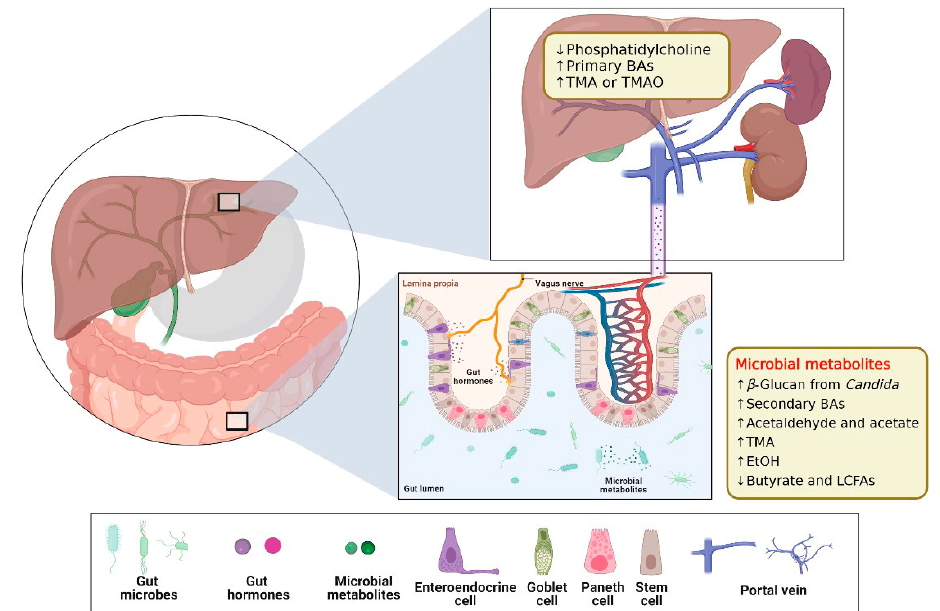
Figure 6. Schematics of Gut–liver Axis (GLA). The gut luminal environment, including the gut microbiome, affects the physiology and behavior of the liver via multiple routes. Created with BioRender.com. The reproduction of this image has been licensed from BioRender.